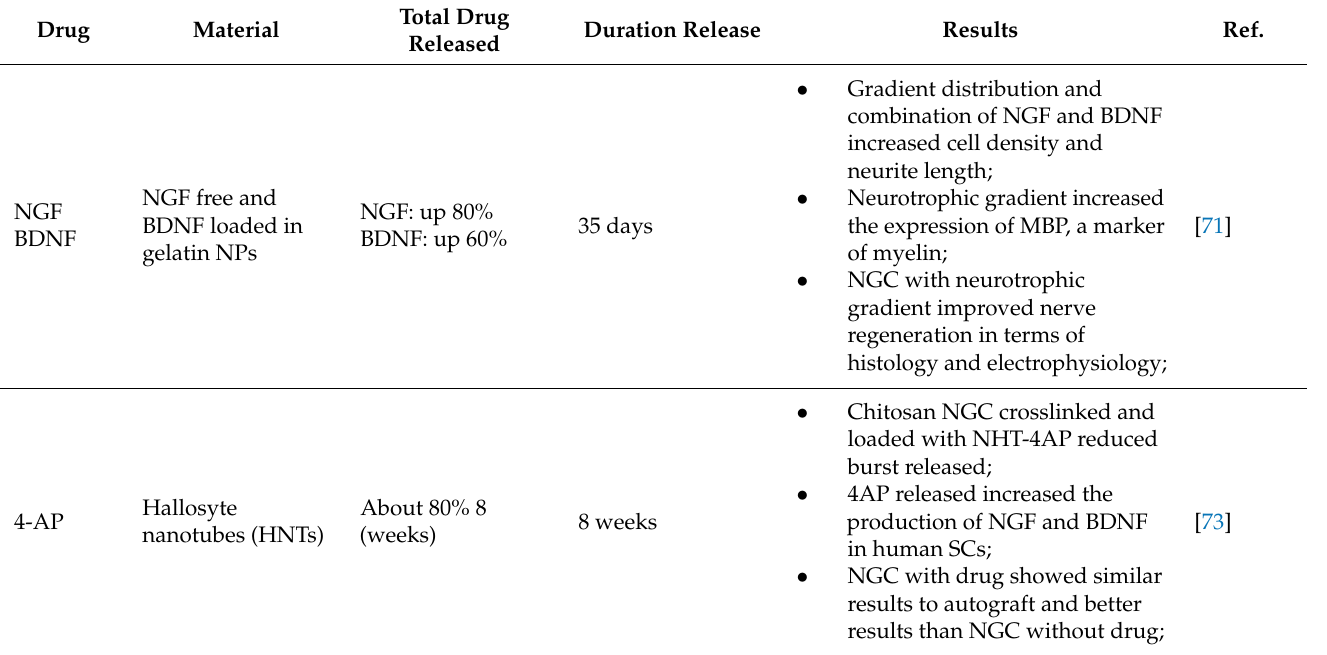
Table 3. Schematic list of nanoparticle studies to enhance nerve